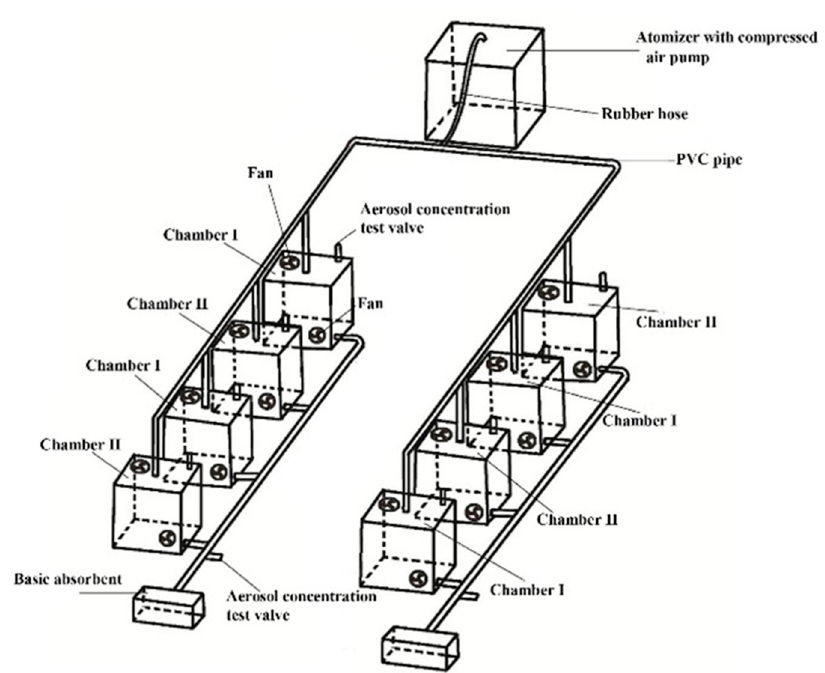
Figure 1. Experimental setup diagram of one application concentration of inorganic nitrogen fumi- gation. Chambers I and II were for the two types of tested plants ( Iris germanica L. and Portulaca grandiflora Hook.). The aerosol concentration test valve was for the monitoring of aerosol concentra- tion, which was only opened for concentration checking during fumigating. The basic absorbent was sodium bicarbonate solution. The fans were for the uniform distribution of aerosols, temperature, and CO 2 , vertically and horizontally.